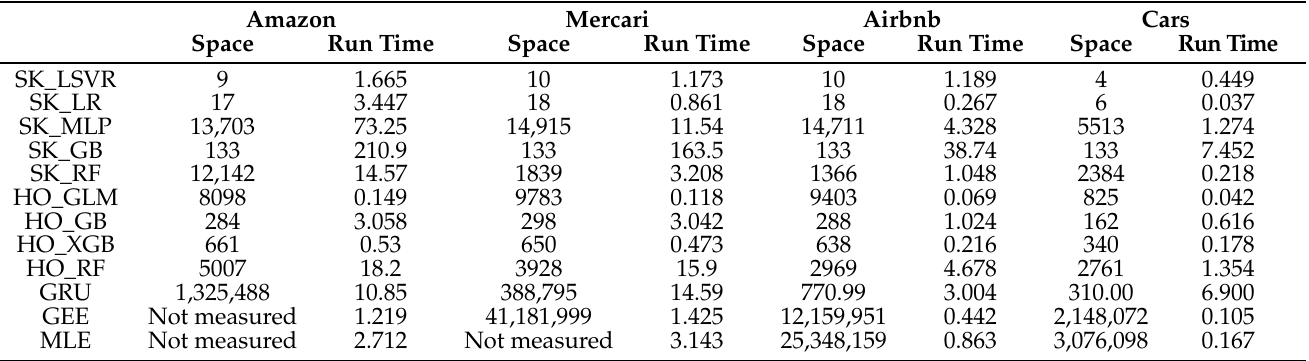
Table 6. Models’ sizes on disk in KB and model fitting times in